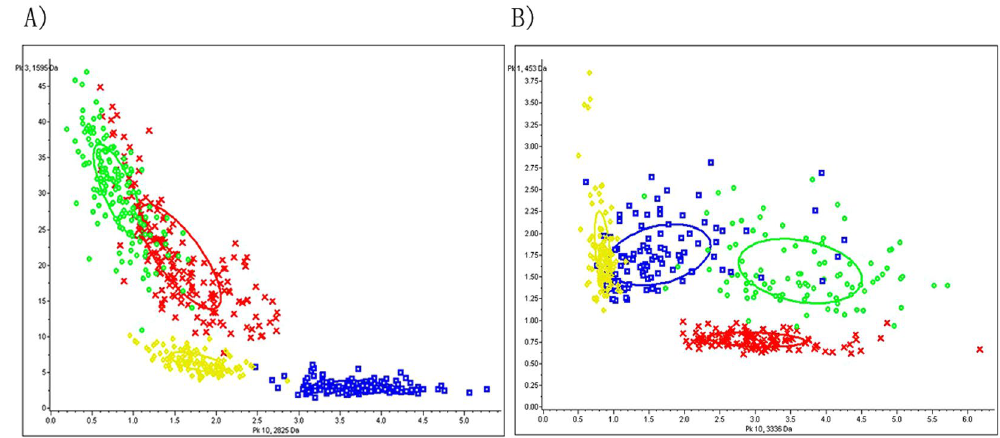
Figure 6. Two-dimensional peak distributions of peptides with m / z = 2825.524, 1595.481, 3335.815, and 453.348 for different PMI groups. ( A ) In SD rat liver samples; ( B ) in human liver samples.